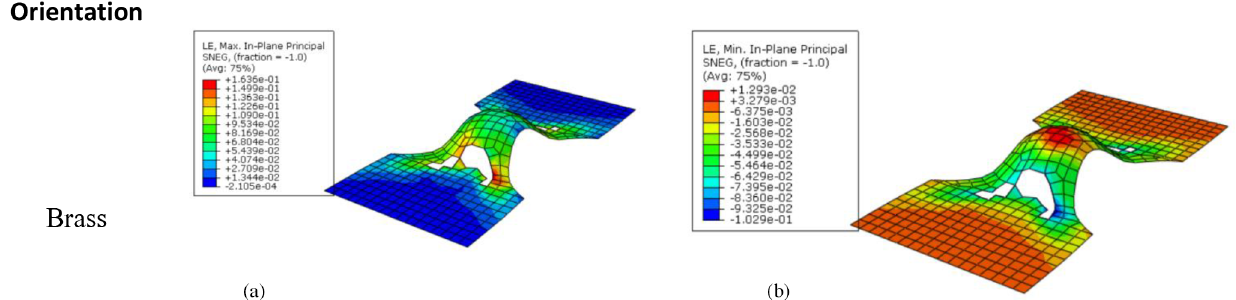
Fig. 4. (a) Maximum in-plane principle strain under uniaxial stretching. (b) Minimum in-plane principle strain under uniaxial